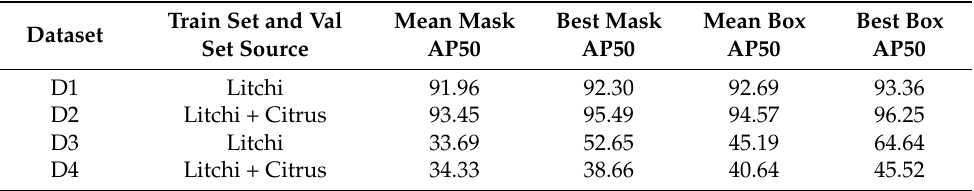
Table 9. Performances of the models trained with different datasets.